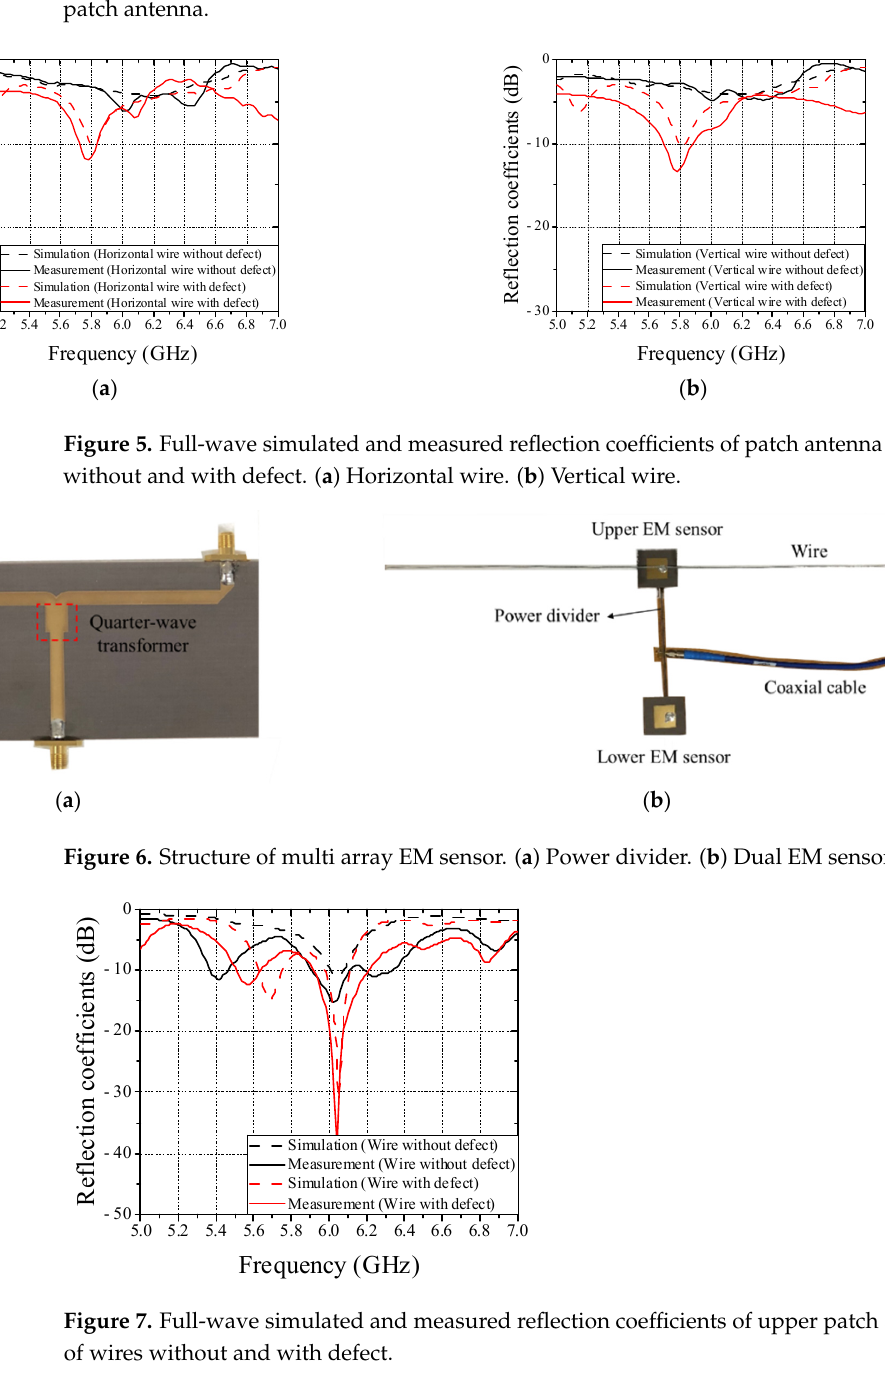
Figure 7. Full-wave simulated and measured reflection coefficients of upper patch antenna in cases of wires without and with